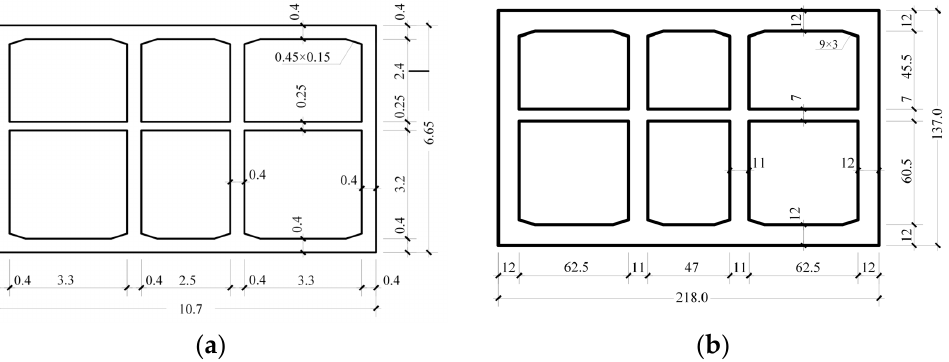
Figure 3. The cross-section dimension underground structure. ( a ) Prototype structure (unit m); ( b ) model structure (unit mm).